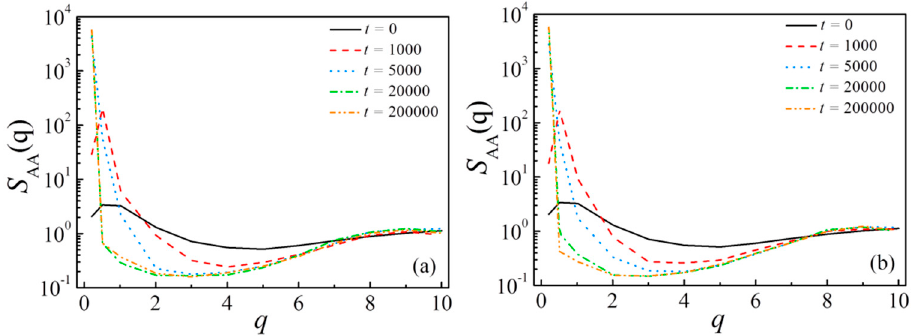
Figure 2. Structure factor of the beads A in homopolymer A n for the cases of ( a ) A 8 / A 4 B 4 / B 8 and ( b ) A 8 / A 2 B 4 A 2 / B 8 at different simulation times. Copolymer concentration is set as c cp = 0.05.